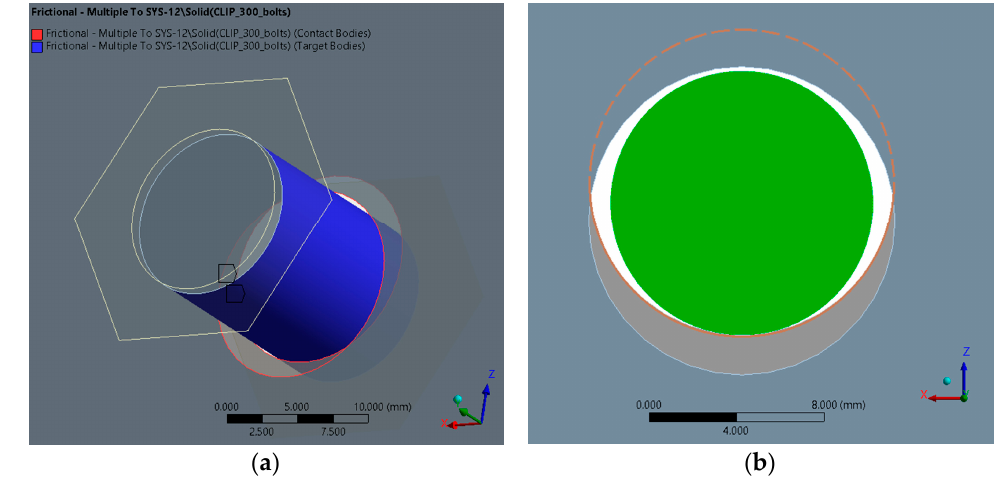
Figure 7. Contact pair between the holes of ( a ) the pair of Z profiles and ( b ) the bolt